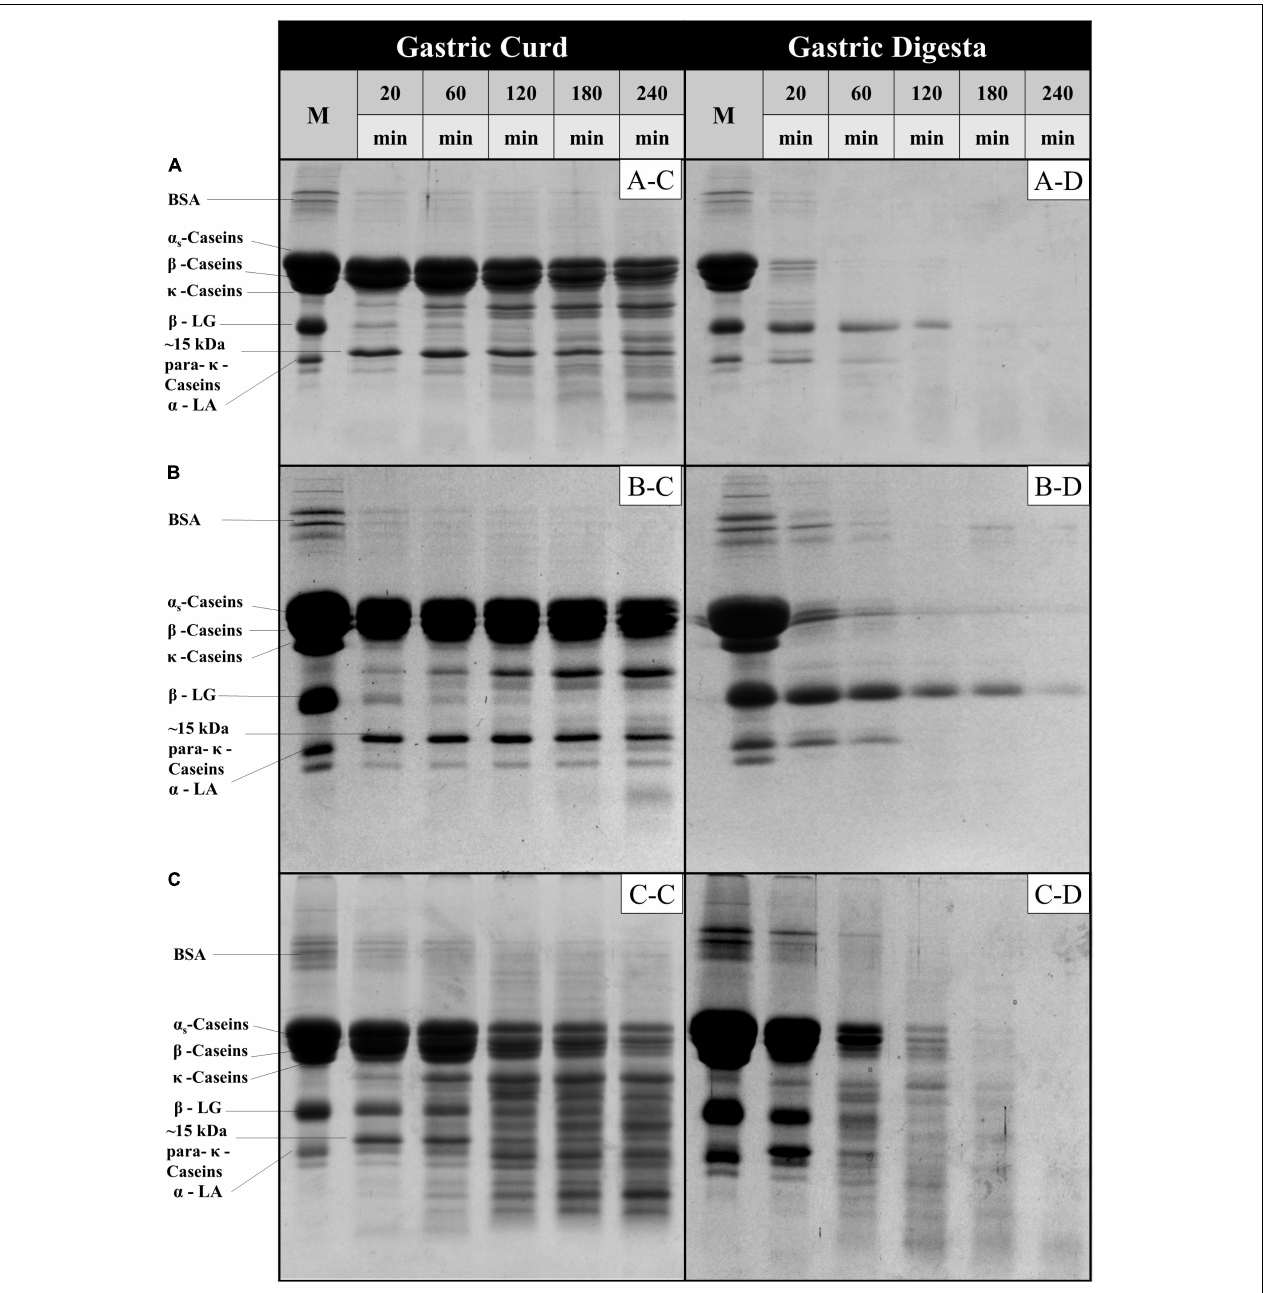
FIGURE 4 | SDS-PAGE patterns (under reducing conditions) of freeze-dried gastric curd (C) and liquid digesta (D) samples obtained at selected timepoints of gastric digestion of MLH (A) , MMH (B) and MHH (C) . M stands for the original samples before digestion and all other samples are labeled appropriately in the figure.